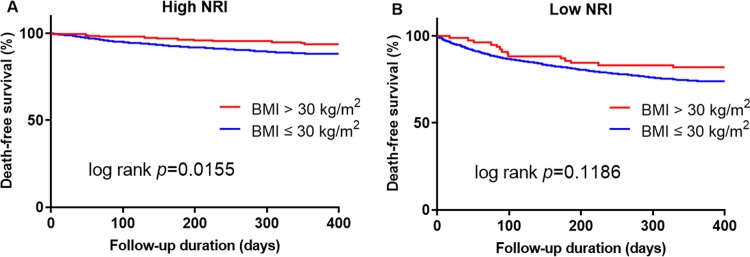
Comparison of death-free survival between patients with body mass index> 30 kg/m2 versus ≤ 30 kg/m2 in high nutritional risk index (A) and low nutritional risk index (B).